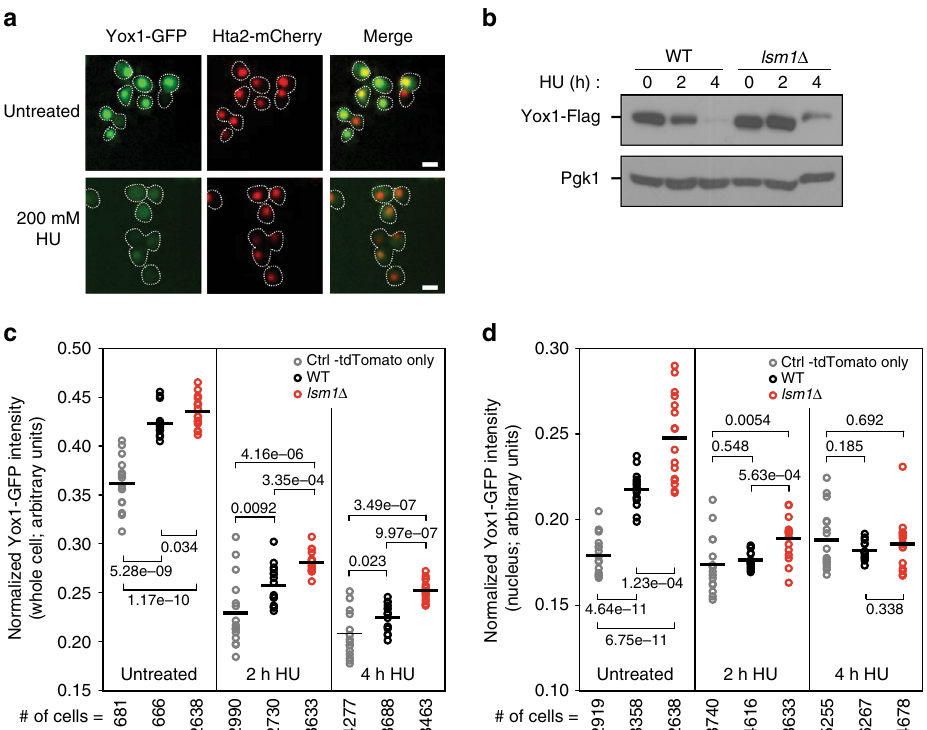
Fig. 5 The Yox1 repressor is more abundant in cells lacking LSM1. a Representative images of cells expressing Hta2-mCherry and Yox1-GFP before and after 2 h of HU treatment. The scale bars are 5 µ m, and the outlines of the cells are indicated. b Analysis of Yox1-Flag protein level by immunoblot before and after HU treatment. Pgk1 was used as loading control. Molecular weight markers are shown on the uncropped image in Supplementary Fig. 5. One representative experiment is shown. Normalized intensity of the cellular ( c ) or the nuclear ( d ) Yox1-GFP fl uorescence in WT and lsm1 Δ cells. Each point represents the data for an individual replicate of the indicated strain (for 8 technical replicates for each of 2 biological replicates). The solid bar indicates the average of the replicates, and P -values from the Student ’ s t -test are